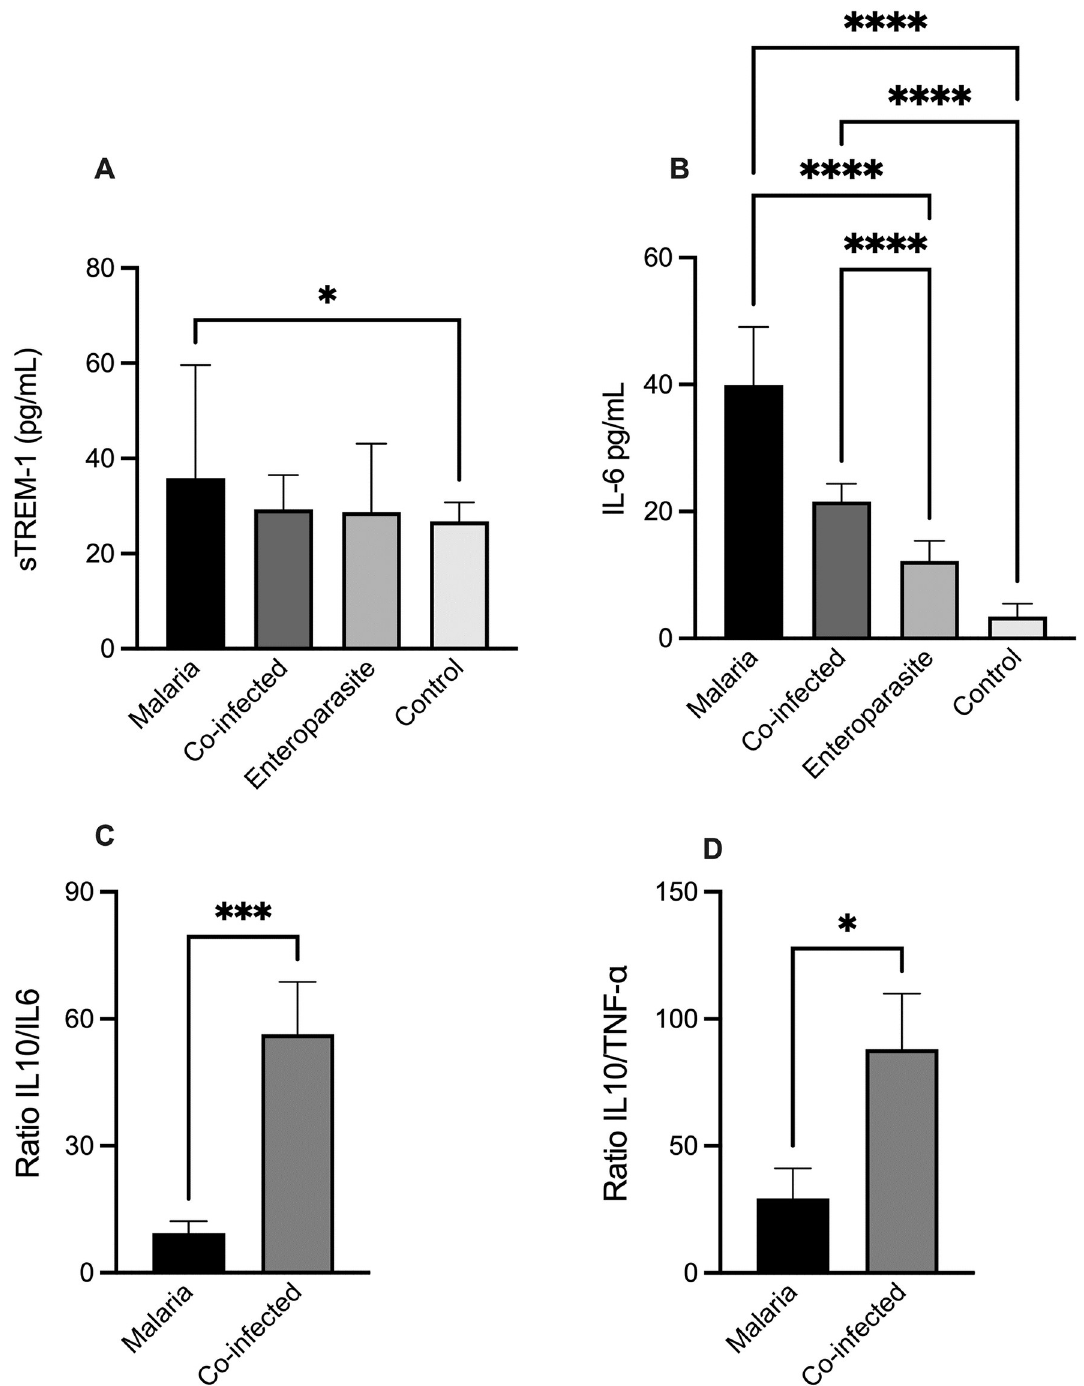
Fig 1. Differential levels of inflammatory mediators during malaria with sTREM-1 and IL-6 serum levels were associated with malaria infection and IL-6 serum levels were also associated during enteroparasites co-infection. (A) sTREM-1 measured in serum samples from malaria-infected individuals (n = 34), co-infected patients (n = 116), enteroparasite patients (n = 120) and healthy controls (n = 95). Bars represent the mean ± standard error ( � P < 0.05, by Mann Whitney test). The asterisk represents a statistically significant difference between the malaria and the control and group. (B) IL-6 measure in serum samples from malaria-infected individuals (black; n = 34), co-infected patients (blue; n = 116), enteroparasite patients (purple, n = 120) and healthy controls (pink, n = 95). Bars represent the mean ± standard error ( ���� P < 0.0001, by Mann Whitney test). The asterisk represents a statistically significant difference between the malaria and the control and group. (C) The ratio between the levels of IL-10 and IL-6 in serum